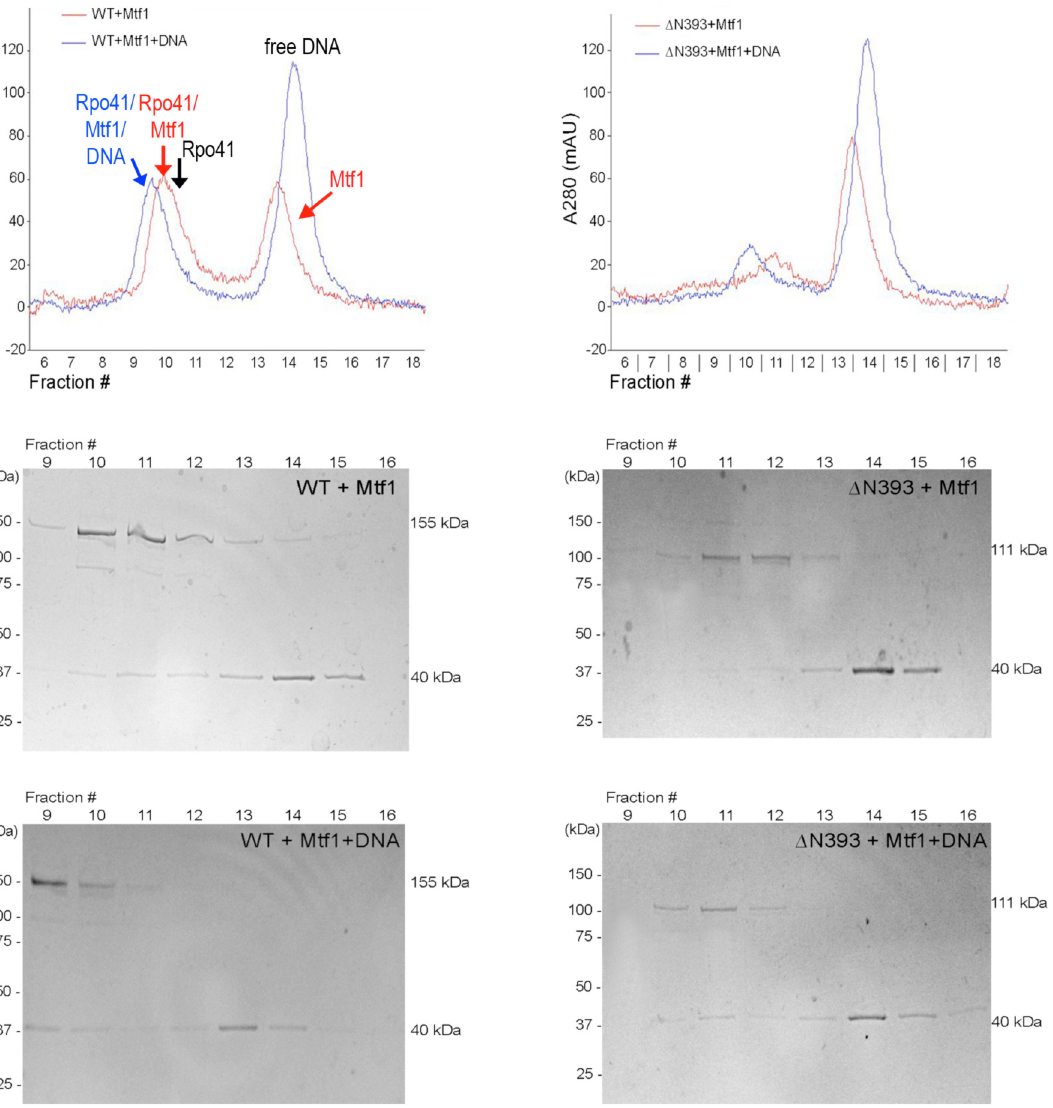
Fig 4. Interactions of Rpo41 with Mtf1 and promoter DNA. (A). Analytical gel filtration chromatograph of wild-type Rpo41 (2.8 μ M) with Mtf1 (5.6 μ M) (red) superimposed with that of Rpo41 (1 μ M), Mtf1 (2 μ M) and a 20bp promoter-containing DNA duplex (3 μ M) (blue). The elution volume of Rpo41 alone is indicated (black arrow). The protein contents of the peak fractions of Rpo41 + Mtf1 and Rpo41 + Mtf1 + DNA were visualized after SDS-PAGE. (B). Analyses described in (A) performed with Rpo41 Δ